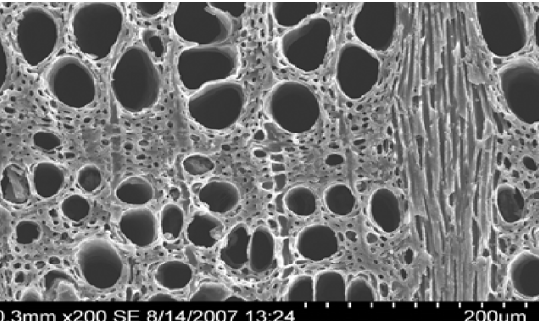
Fig. 1. Porous structure of non-activated biocarbon